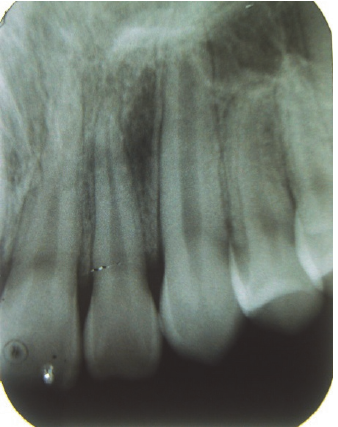
Figure 7: Radiographic control after four years without signs of